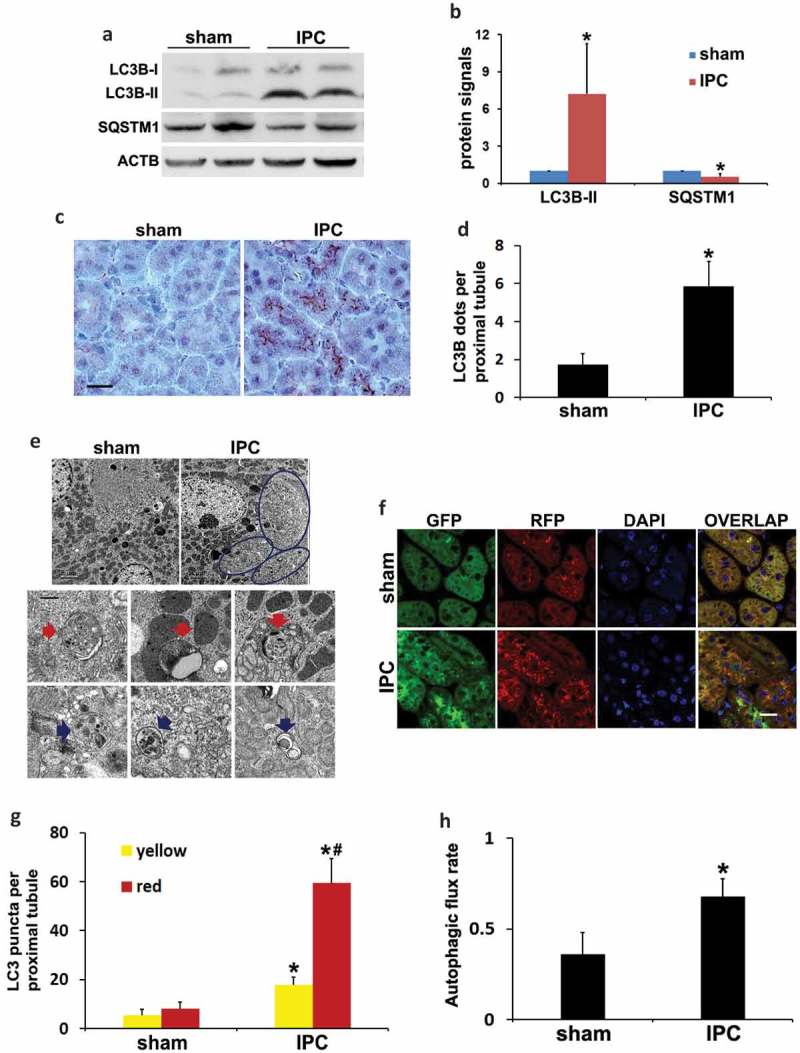
Induction of autophagy in proximal tubules during renal IPC. C57BL/6 (a–e) and CAGp-RFP-GFP-LC3 (f–h) mice were subjected to renal IPC only without subsequent renal IRI (C57BL/6 mice: sham: n = 3; IPC: n = 6; CAGp-RFP-GFP-LC3 mice: n = 3 for each). Kidneys were collected after preconditioning for histological and immunoblot analyses. (a) Representative blots of LC3B and SQSTM1. ACTB was used as a loading control. (b) Densitometric analysis of LC3B-II and SQSTM1. After normalization with ACTB, the protein signals of the sham were arbitrarily set as 1, and the signals of other conditions were normalized to the sham to calculate fold changes. (c) Representative images of immunohistochemical staining of LC3B. Scale bar: 20 µm. (d) Quantitative analysis of punctate LC3B staining. Data in (b and d) are expressed as mean ± SD. *, P < 0.05, significantly different from the sham group. (e) Representative electron micrographs showing autophagic vacuoles (arrows) (n = 2 for each). Scale bar: 2 µm (3 upper panels) and 200 nm (6 lower panels). (f) Representative images of GFP-LC3 and RFP-LC3 fluorescence staining. Scale bar: 15 µm. (g) Quantitative analysis of yellow and red LC3 puncta. Data are expressed as mean ± SD. *, P < 0.05, significantly different from the sham group; #, P < 0.05, values of red LC3 puncta significantly different from the relevant values of yellow LC3 puncta. (h) Analysis of autophagic flux rate. Data are expressed as mean ± SD. *, P < 0.05, significantly different from the sham group.